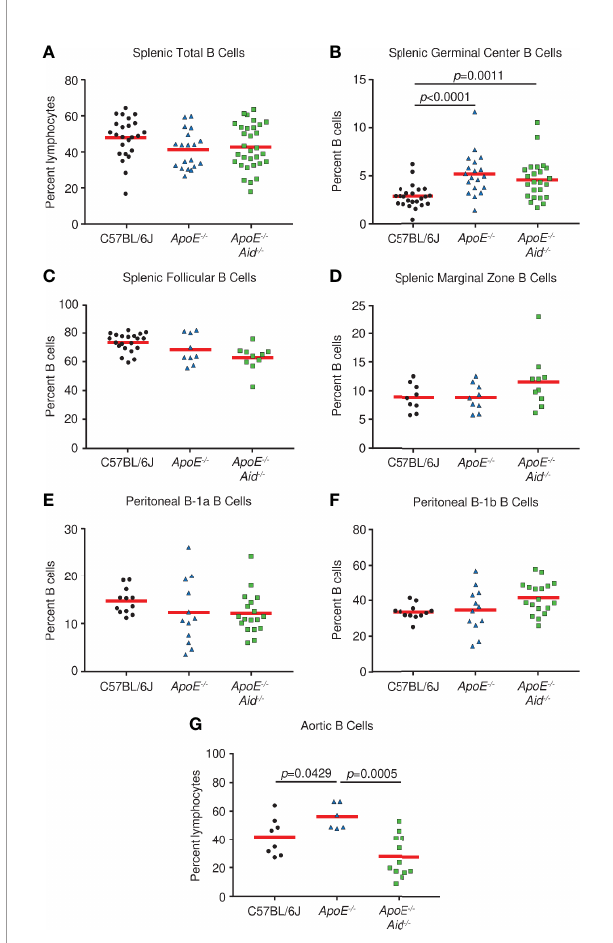
FIGURE 2 | B cell subsets in spleen, peritoneal cavity, and aorta from C57BL/6J, ApoE -/- and ApoE -/- Aid -/- mice. (A) Total, (B) germinal center, (C) follicular, and (D) marginal zone B cells were analyzed from spleens of mice at 28 weeks. (E) B1a and (F) B-1b cells were isolated from the peritoneal cavity. (G) Aortic B cells were isolated from the aorta and adjacent fat layer. Symbols represent percentages in individual mice with red line displaying the mean. p -values represent two-tailed